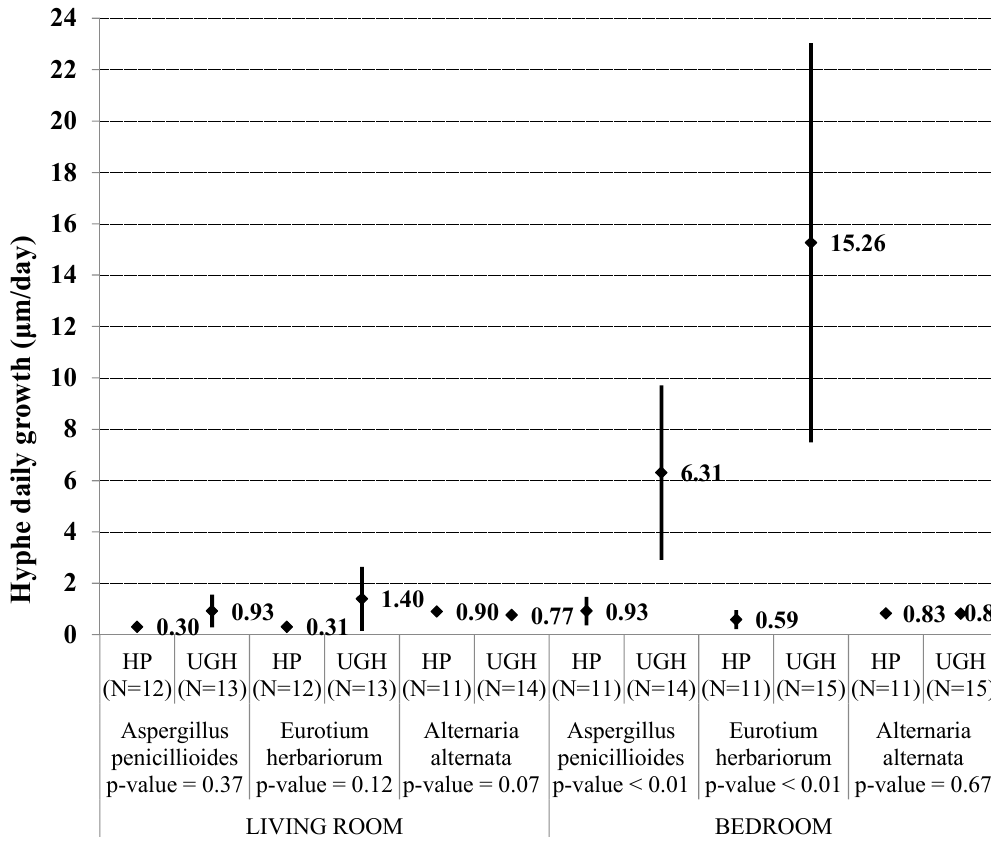
Figure 2. Average daily hyphal growth rate and lower and upper 95% confidence limit in the living rooms and in the bedrooms (outliers